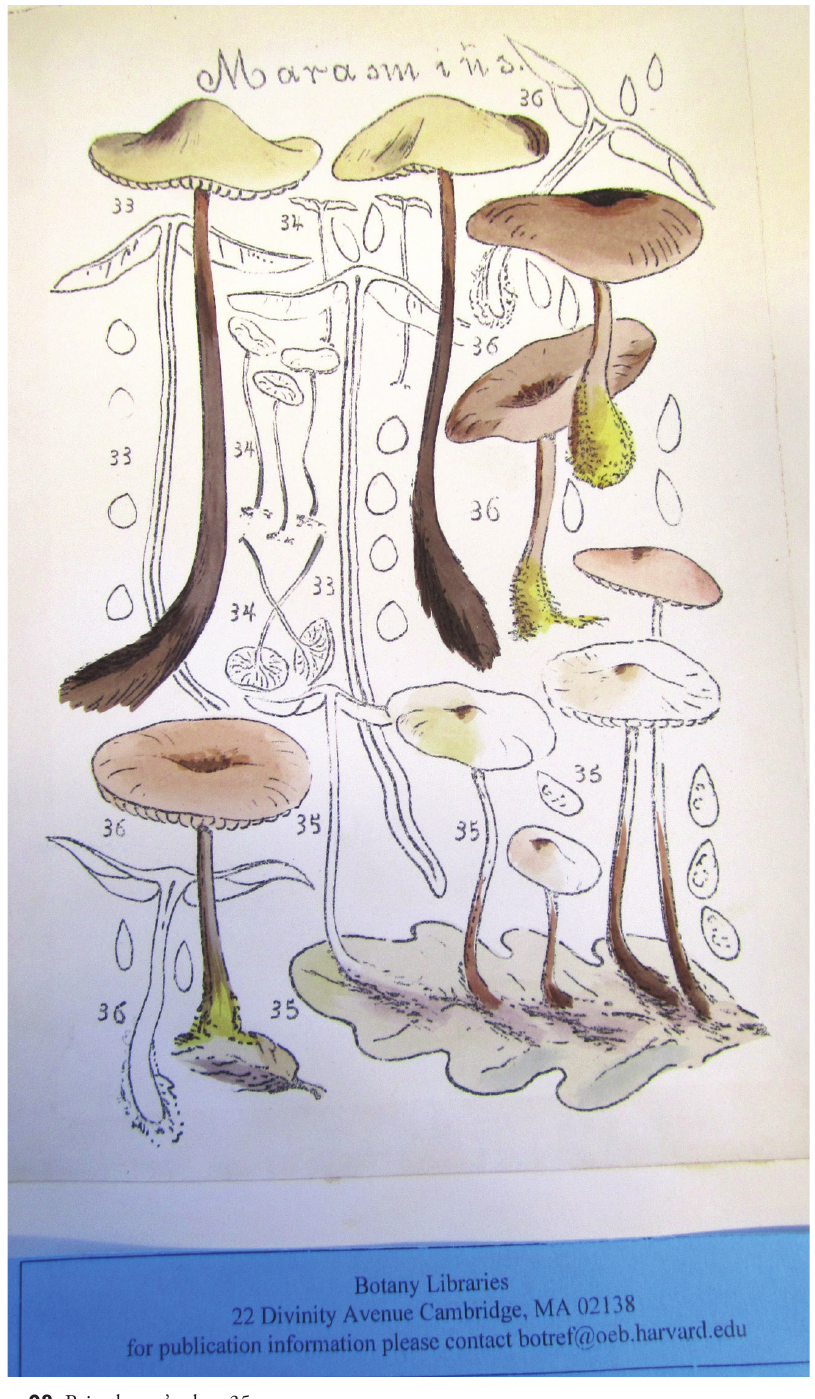
Figure 98. Britzelmayr’s plate